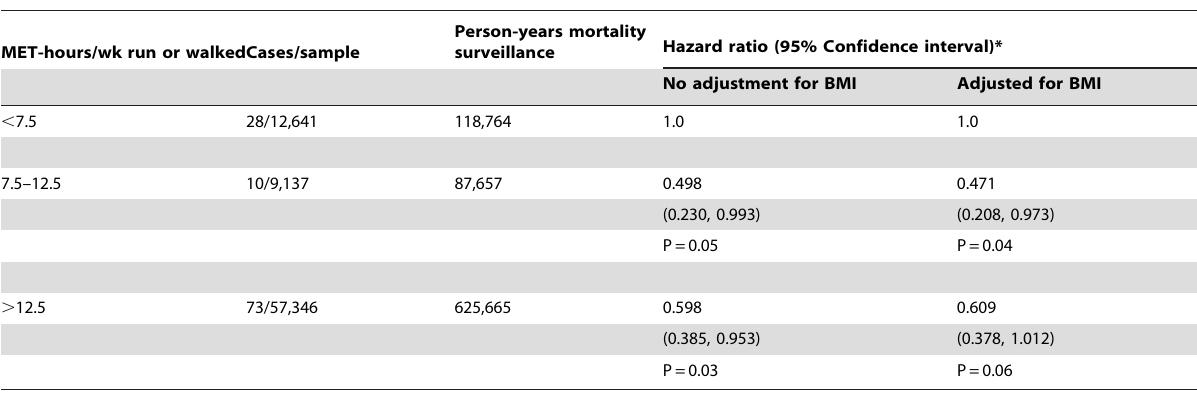
Table 3. Survival analyses for breast cancer mortality by reported exercise level.